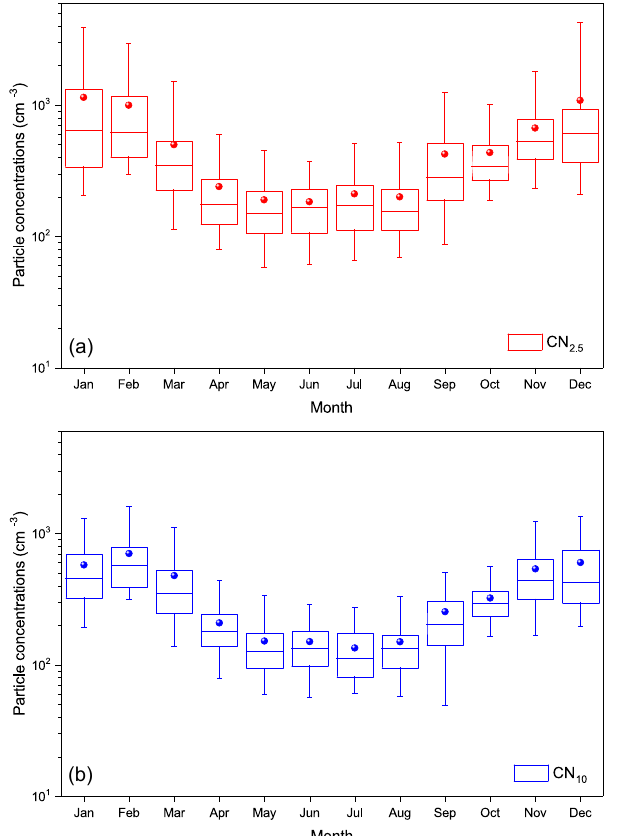
Figure 6. Box plots of seasonality of (a) CN 2 . 5 and (b) CN 10 con- centrations. Lines in the middle of the boxes indicate sample medi- ans (mean value is closed circle), lower and upper lines of the boxes are the 25th and 75th percentiles, and whiskers indicate the 5th and 95th percentiles.